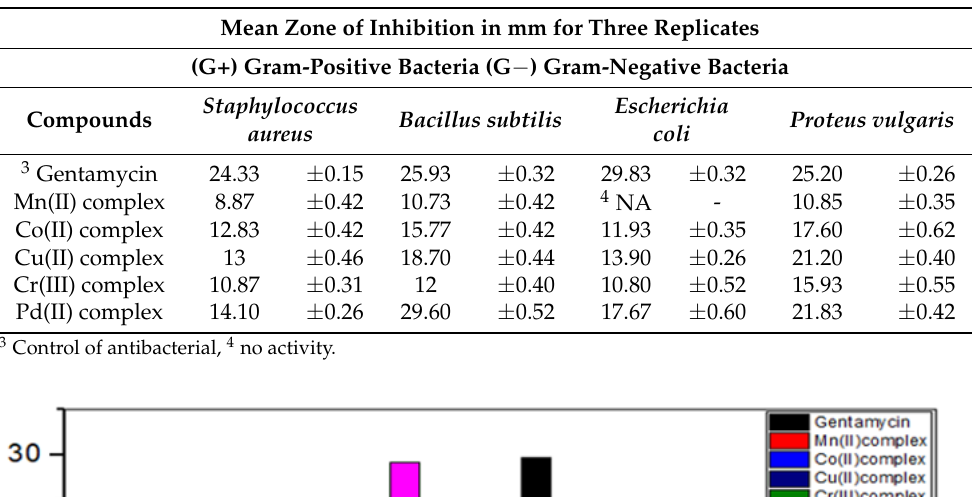
Table 7. Biological activities of the complexes against Gram-positive bacteria.